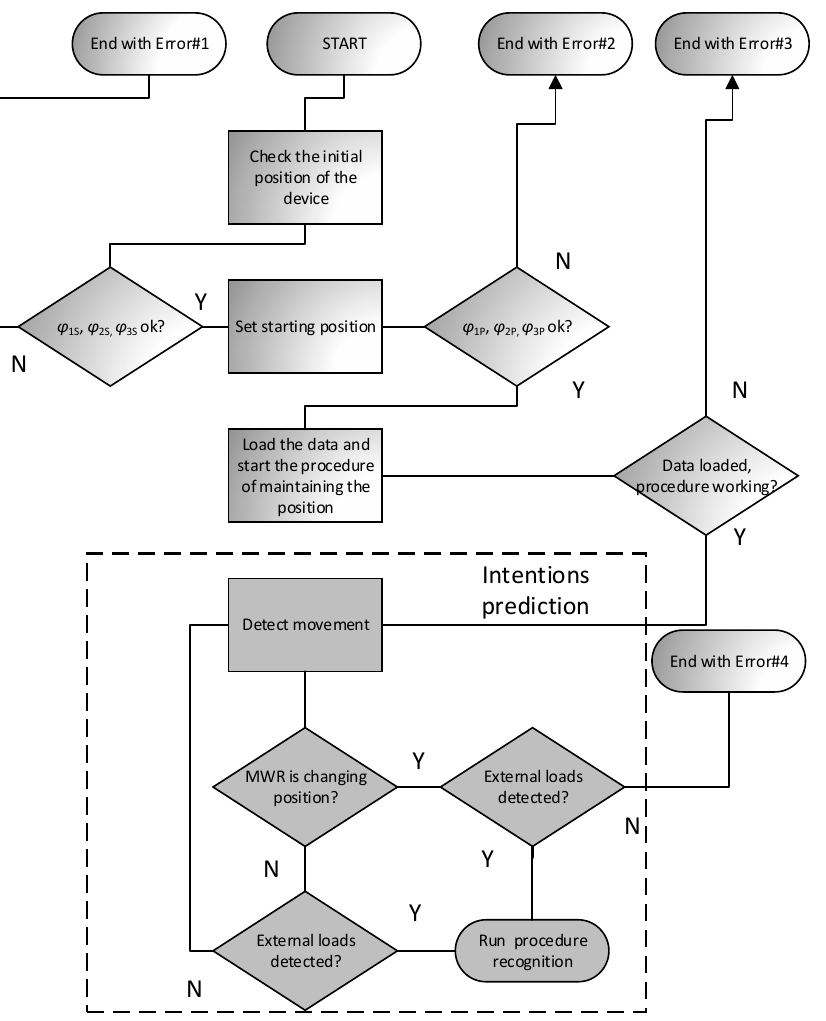
Figure 9. Block diagram of the MWR mechanism operation.